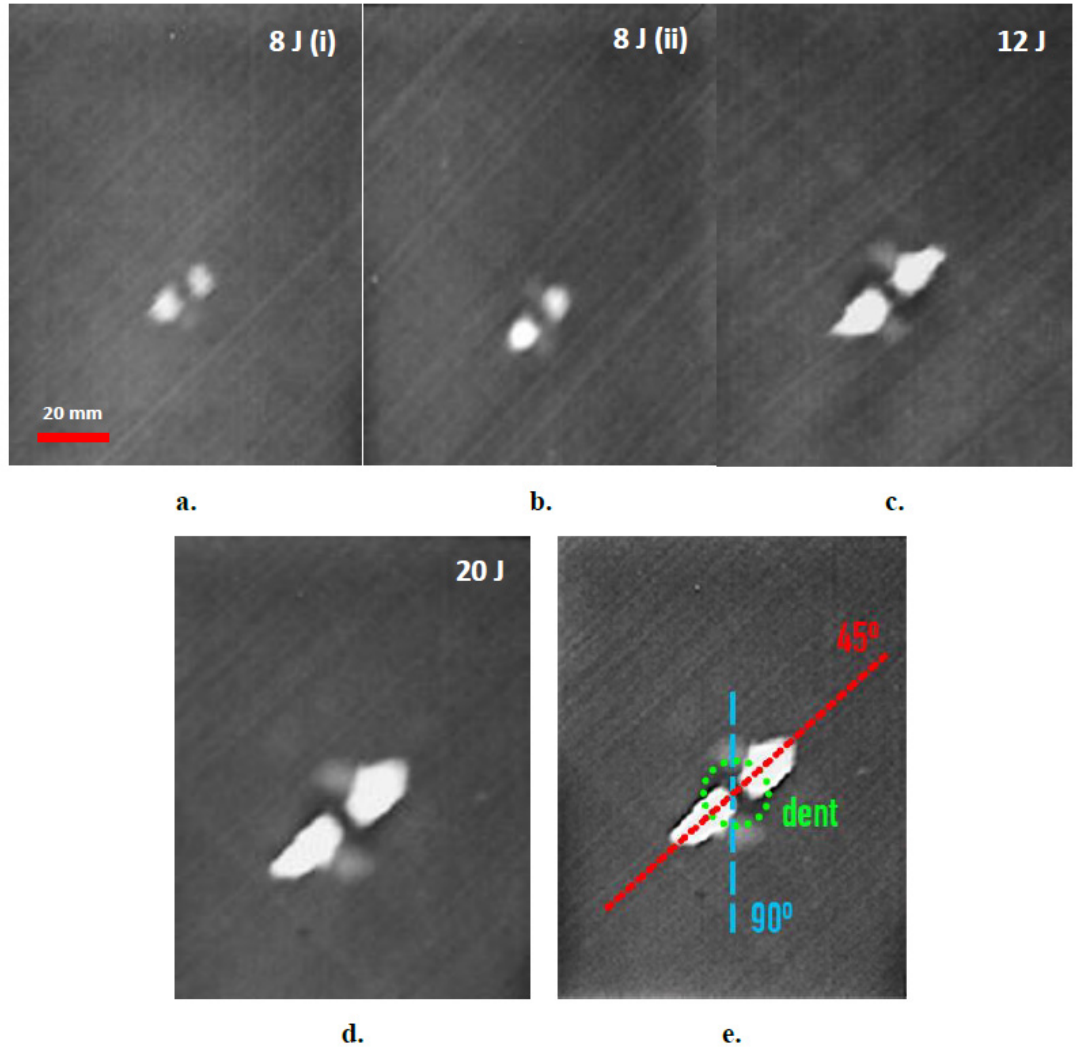
Figure 7. Thermographic assessment of impact damage in thick, 18-layer composite laminates for different levels of impact energies ( a – d ) and schematic of distinguishable damage features ( e